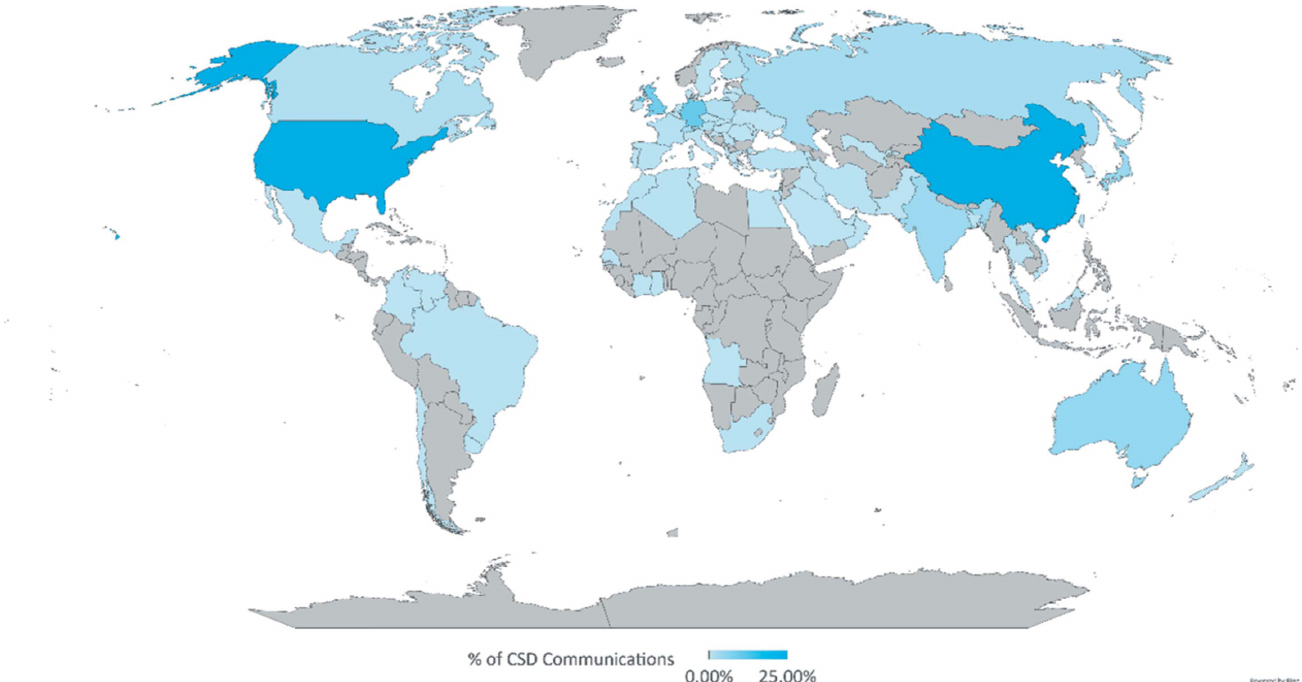
Figure 9 Location of authors of CSD Communications . Colour strength based on percentage of CSD Communications from the